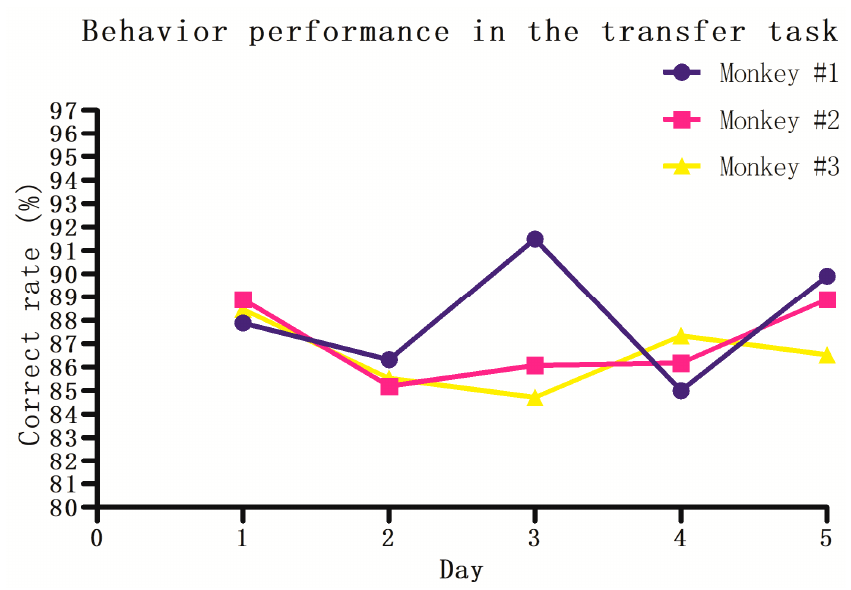
Figure 4. Behavioral performance of all three monkeys in the transfer task. Data shown are the correct rates from the first and the four subsequent daily